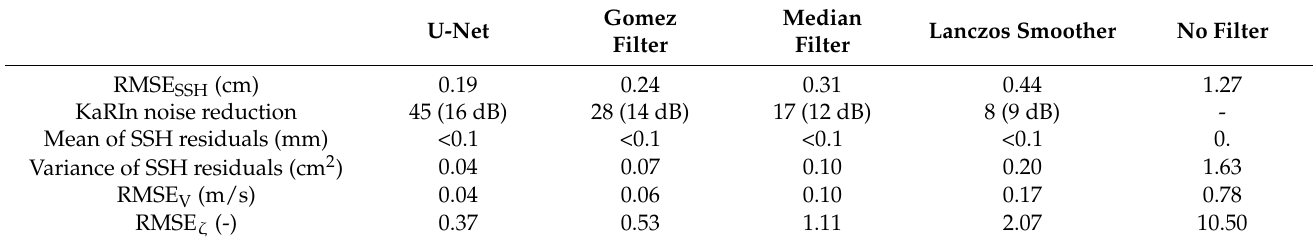
Table 1. Comparison of the offshore (>10 km to the coast) scores between the U-Net, the classical methods and with no filtering computing on the entire domain.